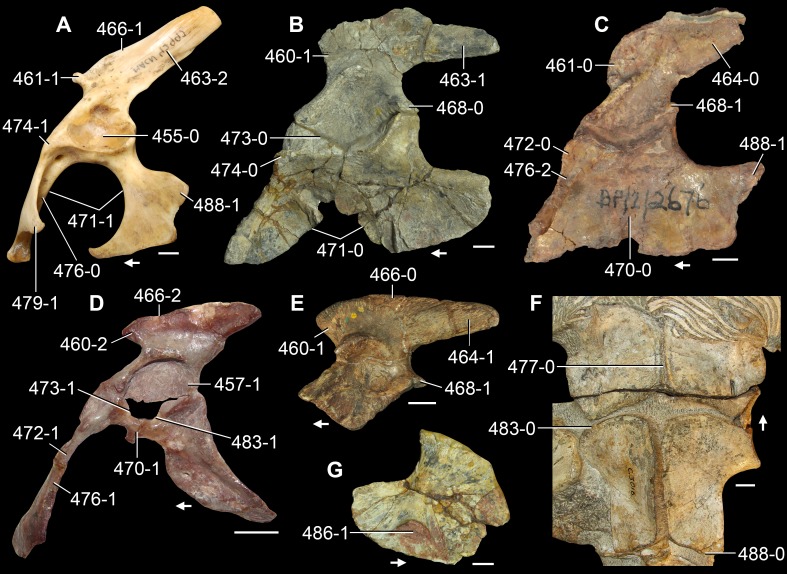
Pelvic girdles of Triassic and Recent saurians in (A–E) lateral, (F) ventral, and (G) medial views.(A) Left hemipelvis of Salvator merianae (MACN-He 47992); (B) left hemipelvis of Pamelaria dolichotrachela (ISI R316/1); (C) left hemipelvis of Prolacerta broomi (BP/1/2676); (D) right hemipelvis of Marasuchus lilloensis (PVL 3870, mirrored); (E) right ilium of Erythrosuchus africanus (NHMUK PV R3592, mirrored); (F) pelvis of Proterosuchus alexanderi (NMQR 1880); and (G) left ischium of Pamelaria dolichotrachela (ISI R316/1). Numbers indicate character-states scored in the data matrix and the arrows indicate anterior direction. Scale bars equal 5 mm in (A, C, D), 1 cm in (B, G, F), and 5 cm in (E).